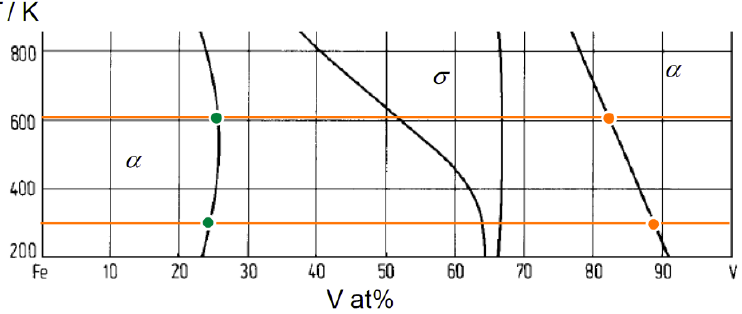
Figure 3. Low temperature part of Fe-V binary phase diagram [31]. 603 K and 297 K are indicated by horizontal orange lines. Fe solubility limit (orange) and V solubility limit (green) at each temperature are marked by individual filled circles.